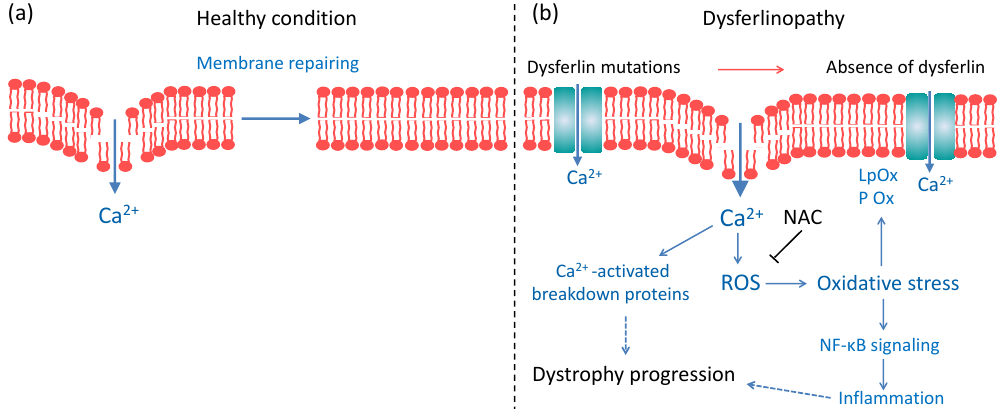
Figure 5. Scheme of mechanisms that might contribute to the dystrophy progression in dysferlinopathies. ( a ) In a healthy condition, the damage in plasma membrane is rapidly repaired, and only a local increase of Ca 2+ is produced. ( b ) In a dysferlinopathy condition, the membrane repair is impaired [6], and non-selective channels, such as connexin-based hemichannels, P2X 7 receptors and transient receptor potential TRPV2 channels are de novo expressed [56,57]. This could contribute to an altered Ca 2+ homeostasis [56], mitochondrial dysfunction [12], ROS production [13], and consequently OS, resulting in lipid peroxidation (LpOx) and protein oxidation (P Ox) [4]. OS further conduces to the activation of the NF- κB inflammatory signaling pathway [ 58]. On the other hand, an altered Ca 2+ homeostasis might also lead to the activation of breakdown protein pathways such as calpains, ubiquitin-proteasome pathway and autophagy [59], whose overactivation also results muscle atrophy [60]. NAC reduces OS and NF- κB inflammatory signaling pathway [ 61].